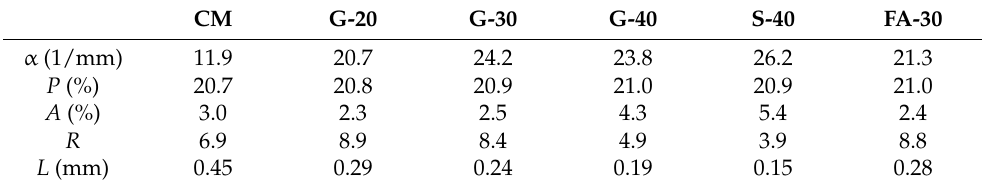
Table 7. Air void